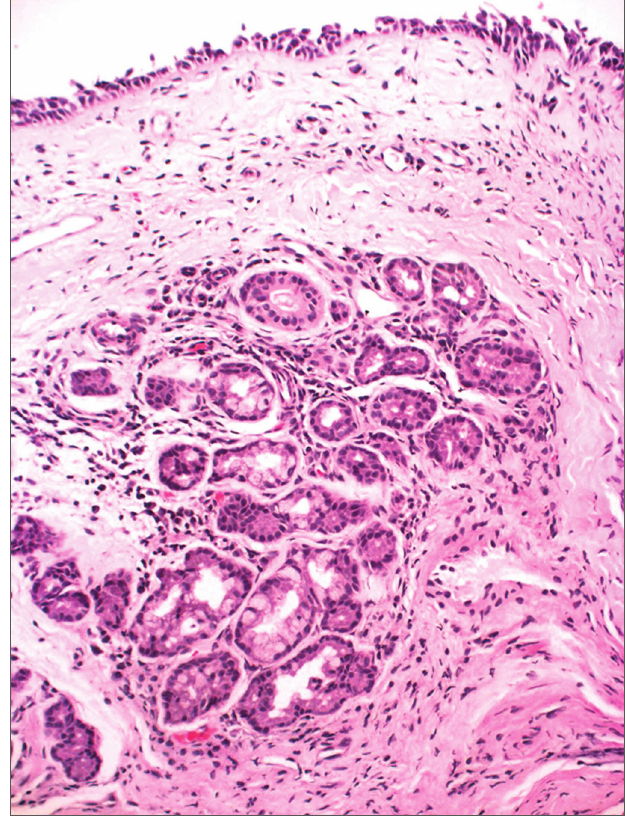
Figura 7. Rinite crônica leve Lâmina com aumento de 200x e coloração por Hematoxilina-Eosina - Lâmina evidencia infiltrado inflamatório dis- creto (células com núcleos roxos permeados por tecido róseo claro) e dilatação glandular (ao centro da lâmina - aspecto